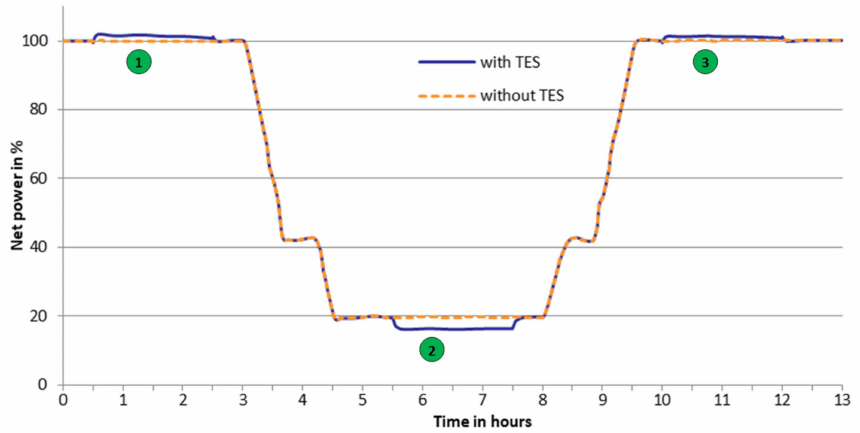
Figure 8. Course of net power over the entire simulation period (Flue gas-Air_indirectly concept).